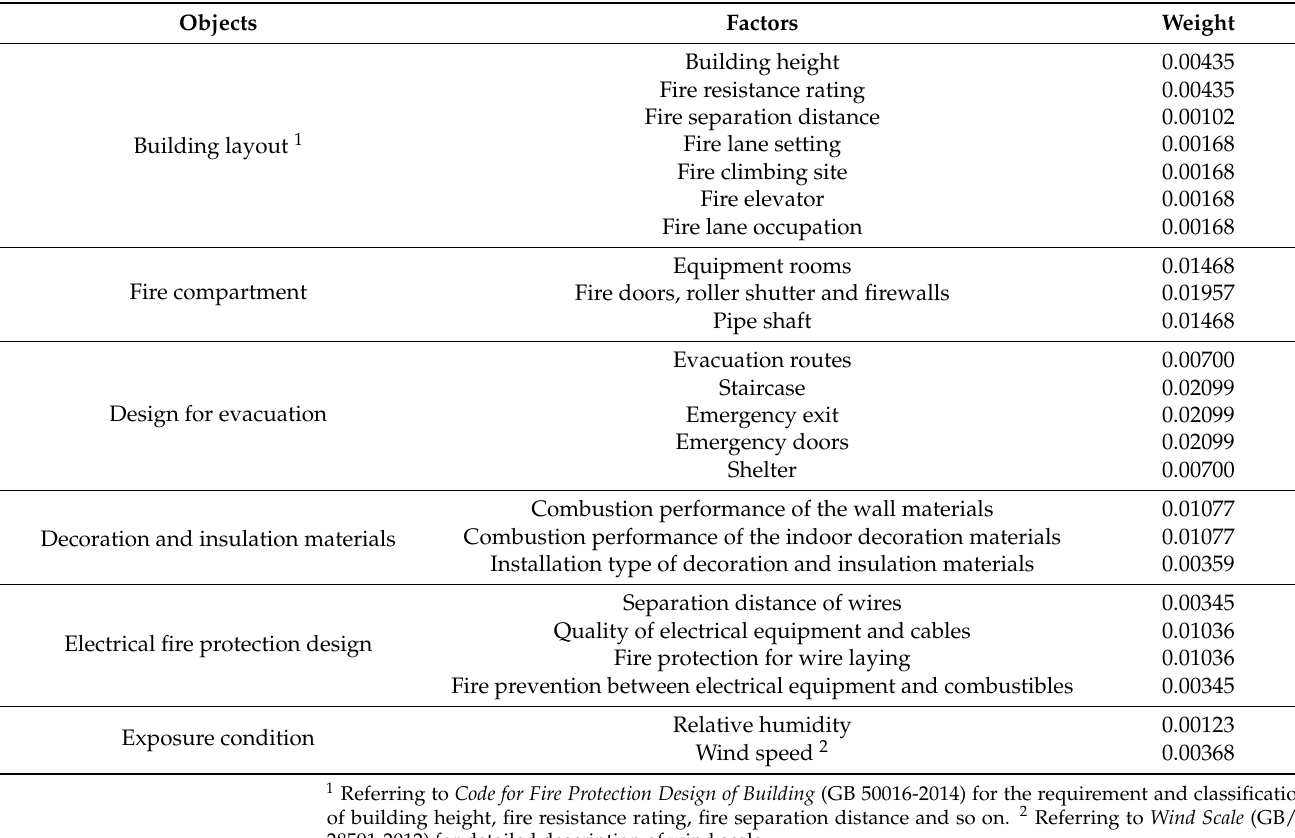
Table A1. The description and weight of each factor under the global factor of fire protection design.